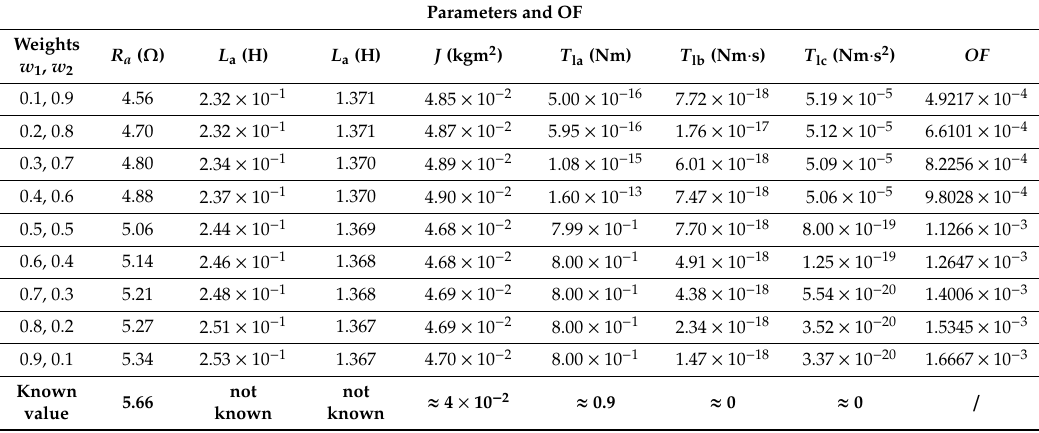
Table 20. Calculated parameters with di ff erent weights using RK for MD1 (mean values for 50 independent